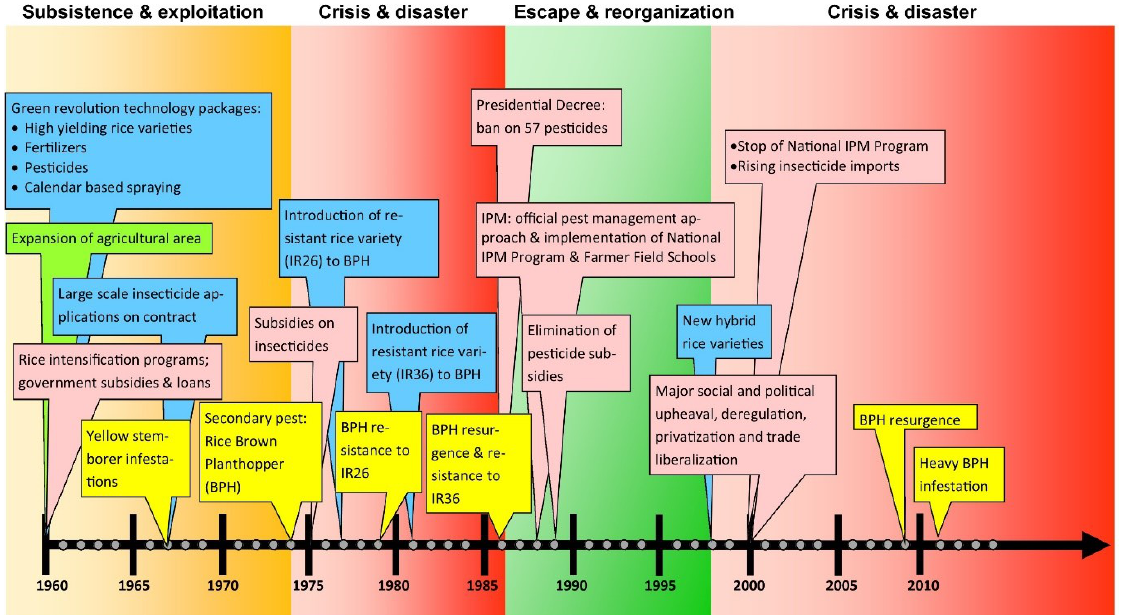
Figure A1.3 : Timeline representing enabling and disabling drivers (text balloons) of pesticide use in rice production in Indonesia from 1960-2015. Colours referring to domains in the framework: farming (yellow), agro-landscapes ( green), science & technology (blue), and society (pink). The colours in the background (orange-red-green) indicate the transition to a new phase of the